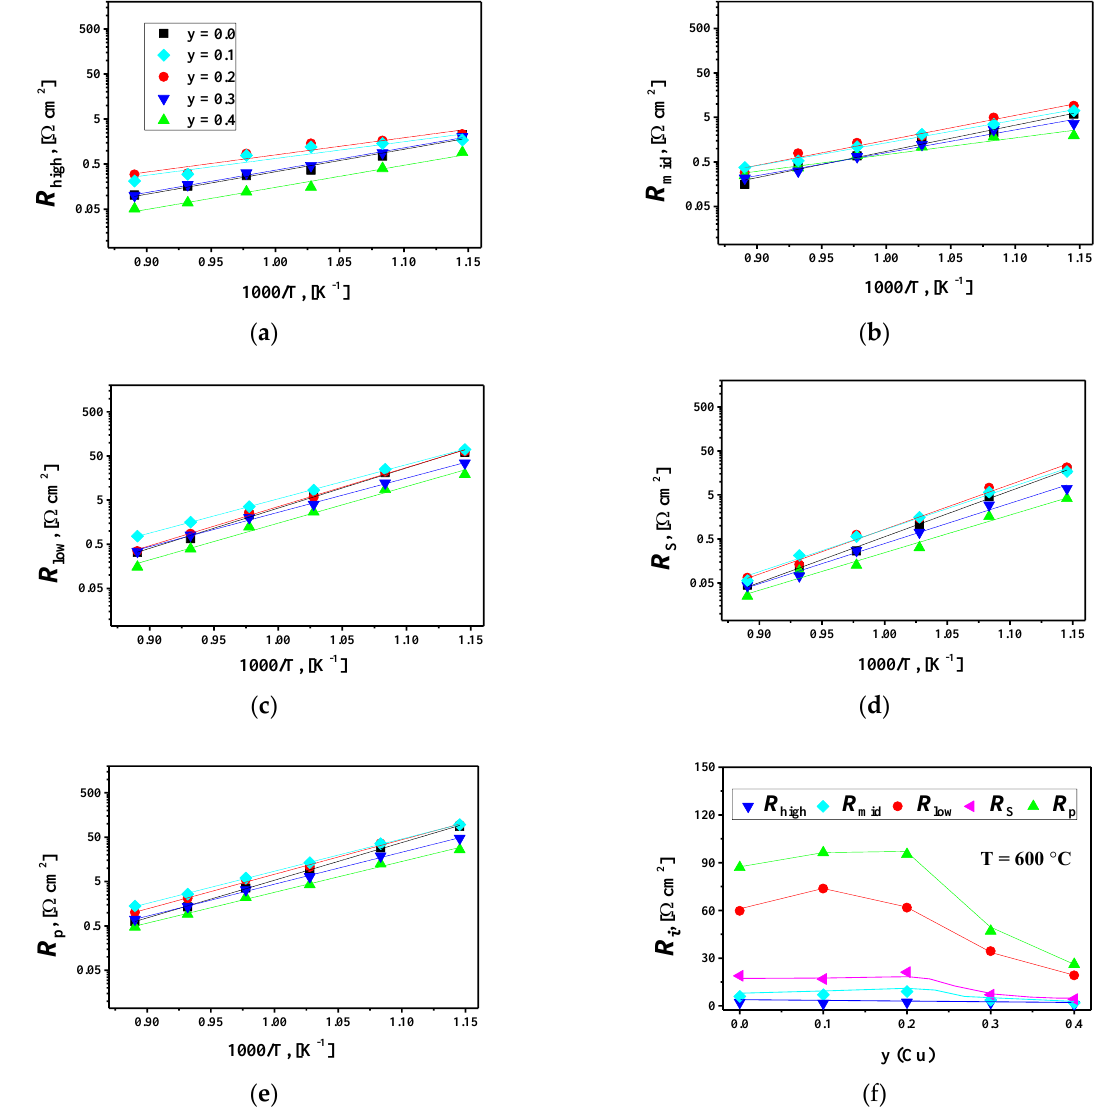
Figure 9. Partial contributions to the electrode polarization resistance and the total polarization resistance R p on: ( a – e ) temperature, and ( f ) Cu content for the La 1.7 Ca 0.3 Ni 1−y Cu y O 4+δ /SDC symmetrical cells sintered at 1000 °C.